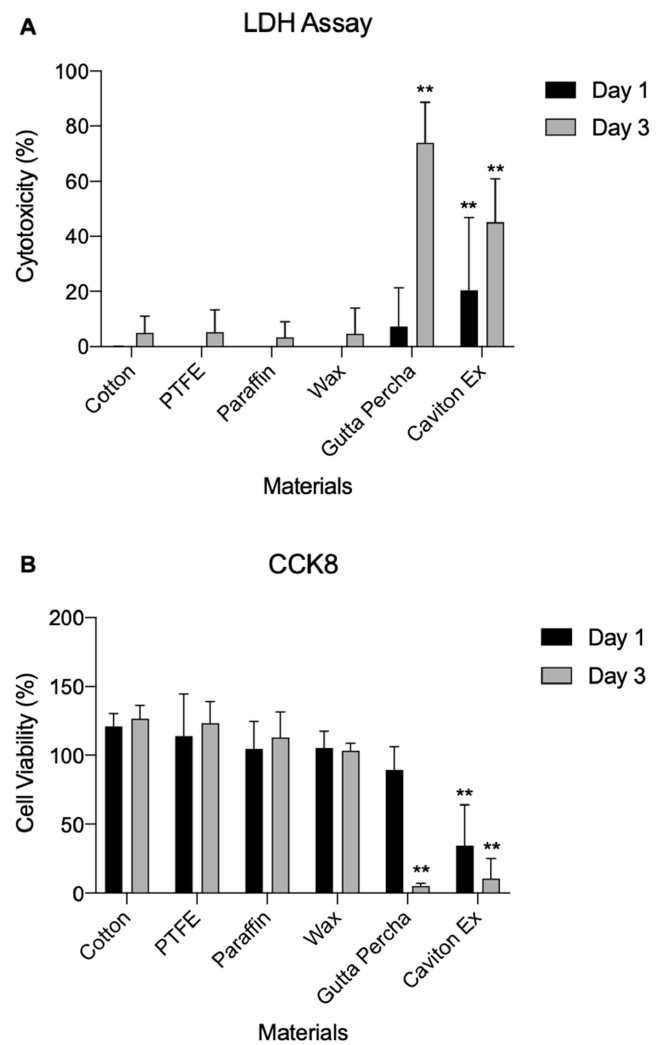
Figure 5. GE-1 cells cytotoxicity test. ( A ) Lactate dehydrogenase assay of the materials against GE-1 cells. The cells were incubated with the materials for 24 and 72 h. ( B ) Cell counting kit 8 assay of the materials. GE-1 cells were cultured for 24 and 72 h. Data are expressed as mean ± standard deviation ( n = 10; ** p < 0.01 vs. cotton